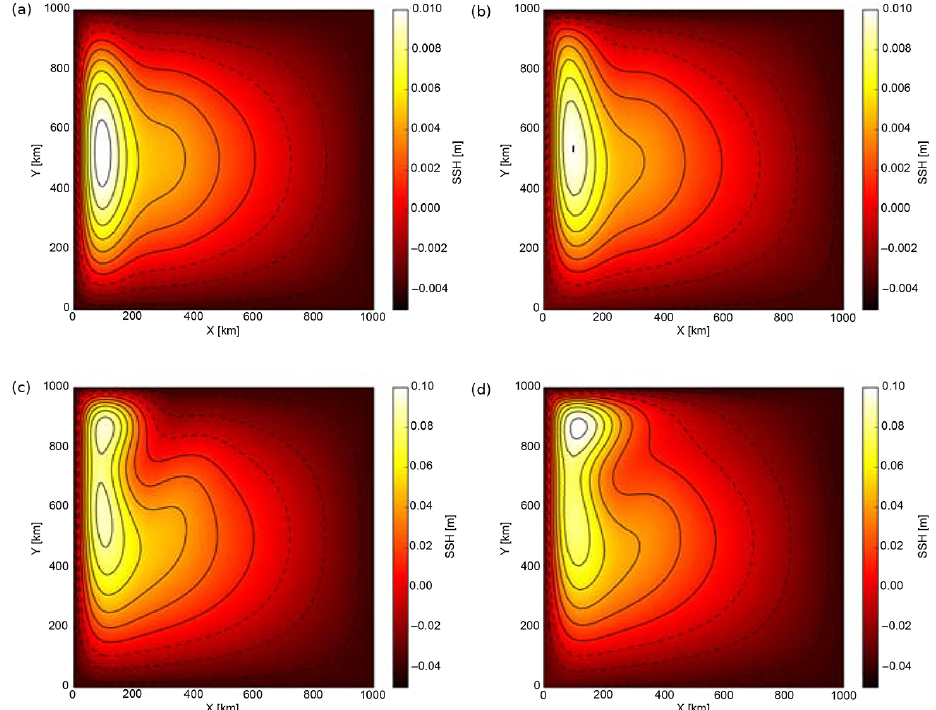
Figure 10. Comparison of QG and ADCIRC for a simplified midlatitude ocean configuration. Shown is the equilibrium SSH for a square domain basin of equal depth, driven by surface wind stress using the setup of Viebahn and Dijkstra (2014) (resulting in a single-gyre solution) at two different Reynolds numbers: Re = 1 (a, b) and Re = 10 (c, d) , where Re = UL/A H and U = τ 0 /(ρβ 0 LH) is a characteristic horizontal velocity. In each case, the left panel shows the solution obtained using QG, and in the right panel the ADCIRC solution is